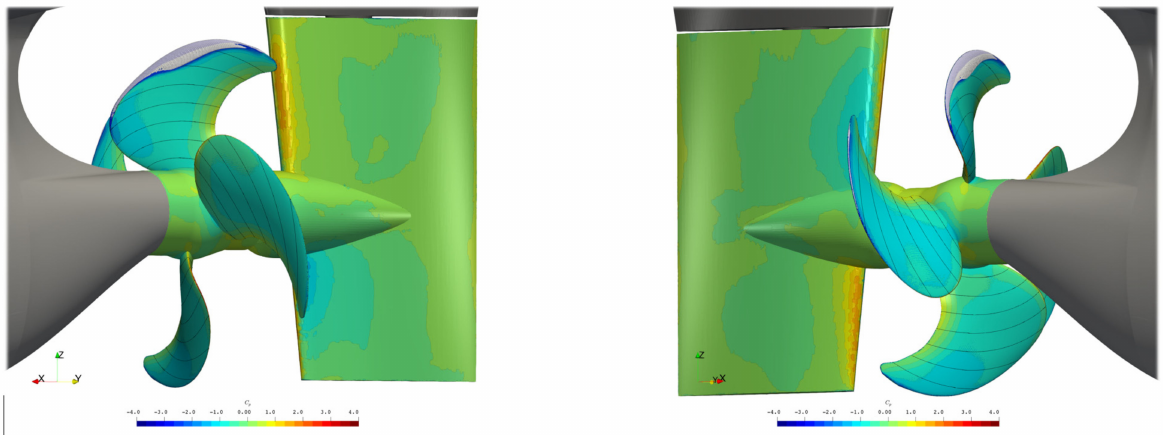
Figure 15. SCHOTTEL reference case 1. The cavitation region (white) and pressure coefficient with one propeller blade located at 12 o’clock